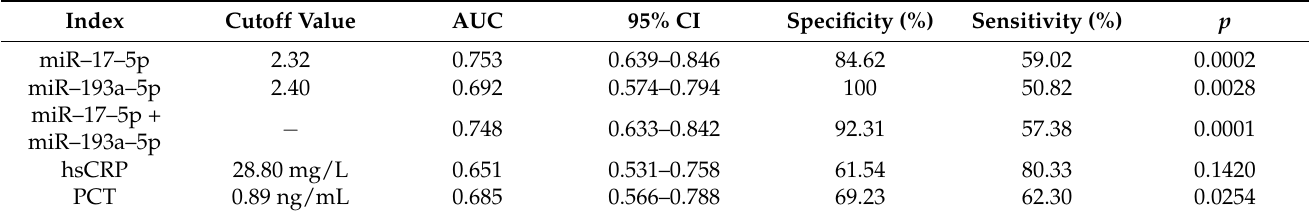
Table 2. Diagnostic value of each index of pneumonia in critical patients.